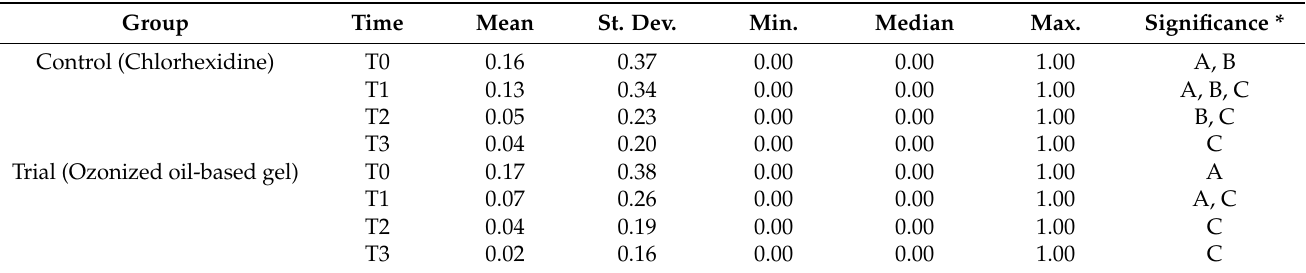
Table 7. Descriptive statistics of Suppuration Index